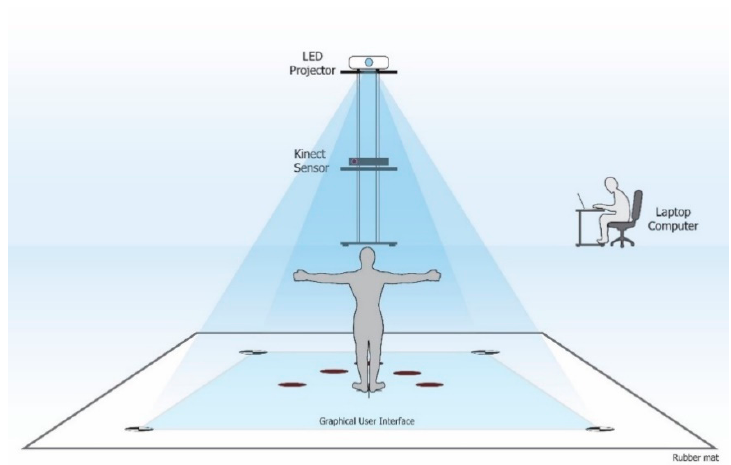
Figure 1. Setting of an interactive game-based training